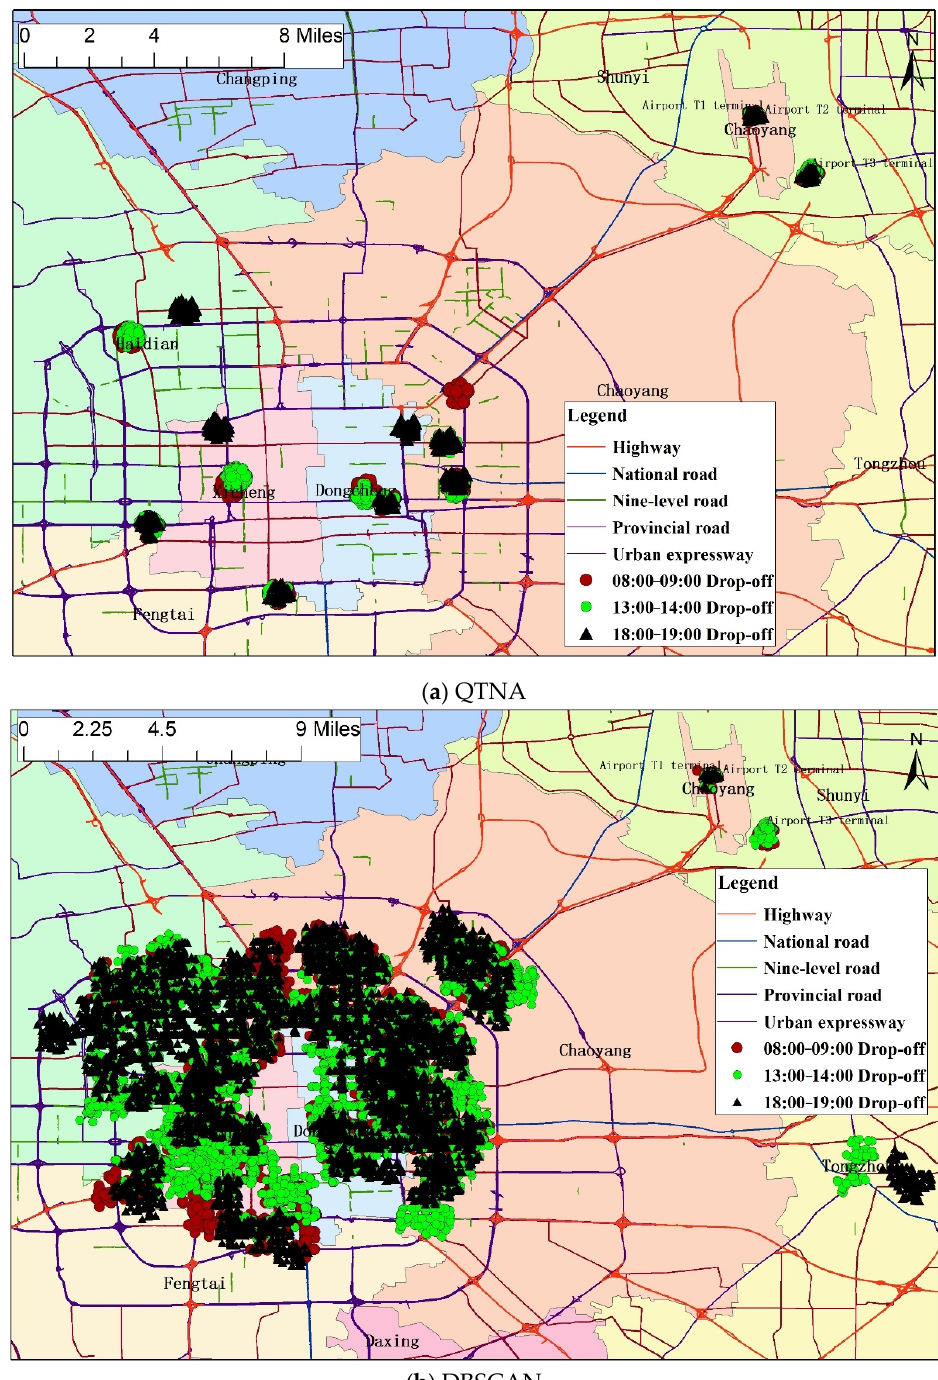
Figure 4. Top 10 hot drop-off areas during different time periods on the same day. Some areas are hot drop-off areas at different time periods. ( a ) shows the detection results of the QTNA algorithm. ( b ) shows the detection results of the DBSCAN algorithm. The DBSCAN algorithm is essentially a process of finding core samples of high den- sity and expanding clusters from them. For any point p , if it is the core point, a cluster C can be formed, with p as the center and r as the radius. The expansion process is conducted